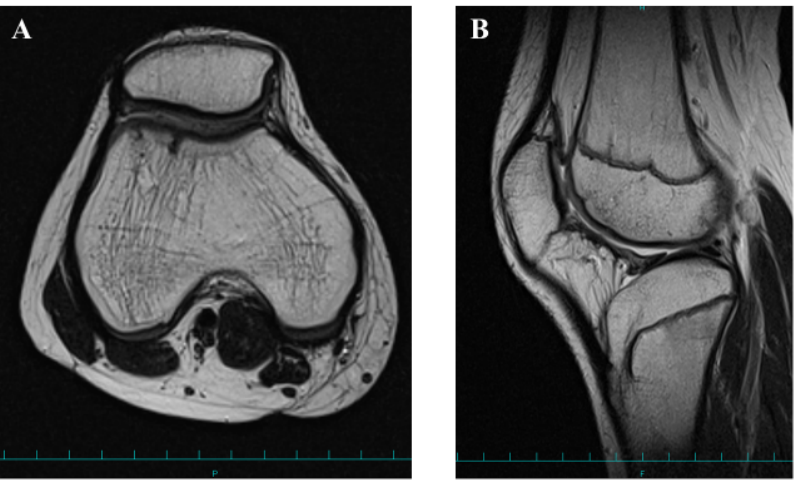
Figure 6. Postoperative magnetic resonance imaging findings (T2 ‐ weighted images) 18 months after surgery. Axial view ( A ). Sagittal view ( B